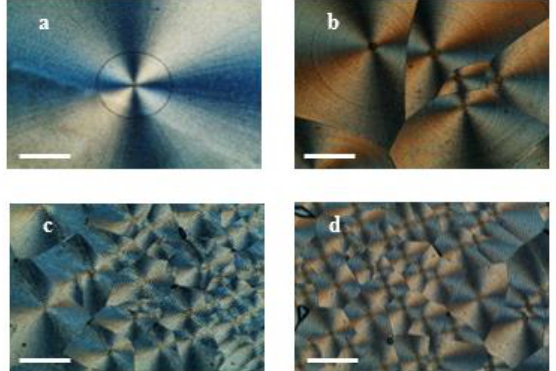
Figure 1. Polarized light optical micrographs of Poly(3-hydroxybutyrate) (PHB) spherulites of the pure PHB and PHB/CpFe + nanocomposites with ratios of ( a ) 100:0, ( b ) 99.5:0.5, ( c ) 99:1, and ( d ) 97:3, respectively, after the isothermal crystallization at 100 °C scale bar 200 µm.